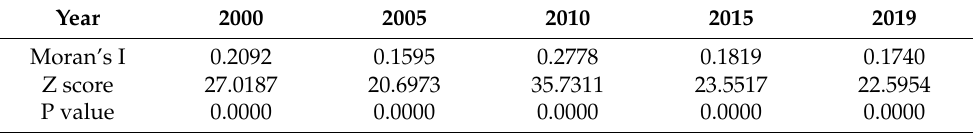
Table 4. Moran’s I of the sustainable development level of urban human settlements in